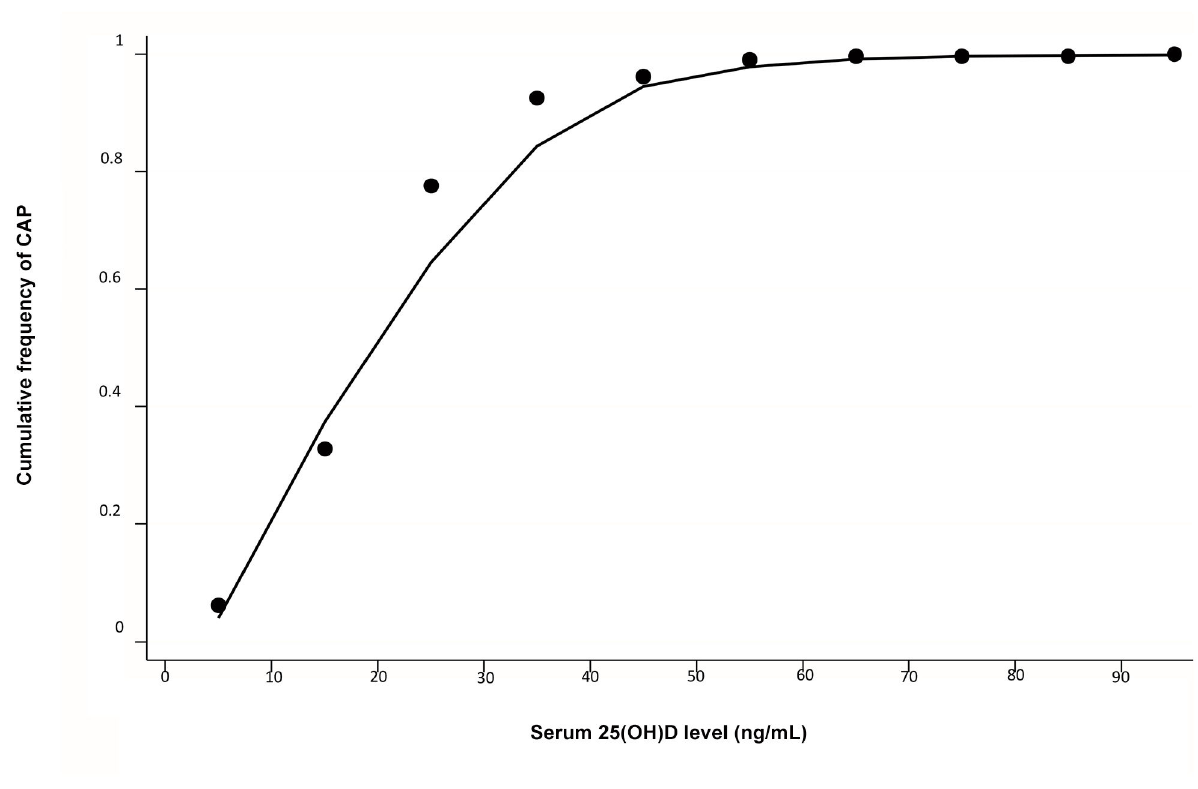
Figure 1. Locally weighted scatterplot smoothing (LOWESS) analysis to show the relationship between increasing 25- hydroxyvitamin D levels and the cumulative frequency of community-acquired pneumonia. CAP = community acquired pneumonia; 25(OH)D = 25-hydroxyvitamin